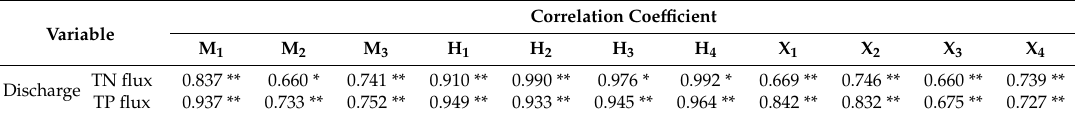
Table 3. ThePearsoncorrelationcoefficientbetweendischargeandTN,TPfluxesofthe11catchmentscales.